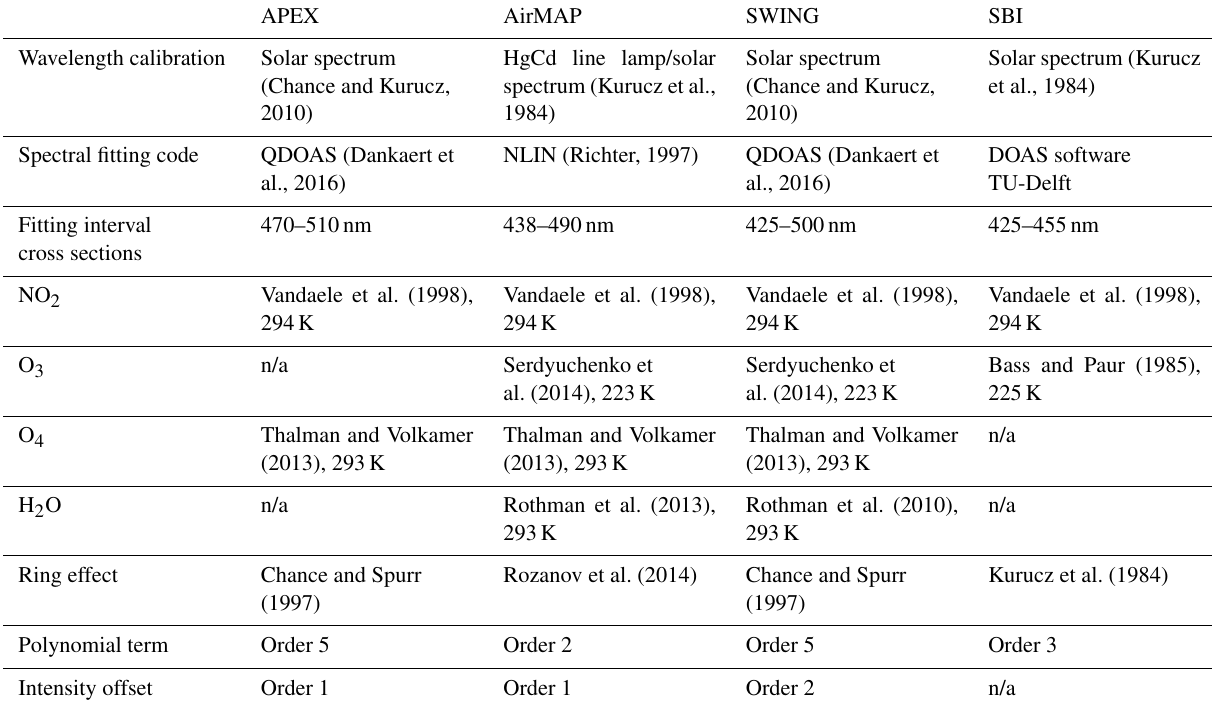
Table 3. Main DOAS analysis parameters and fitted absorption cross sections for NO 2 DSCD retrieval. APEX